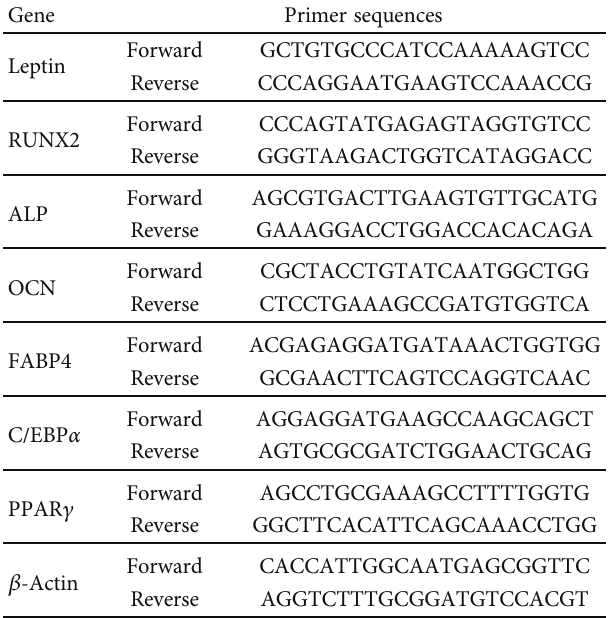
Table 1: The primer sequences for